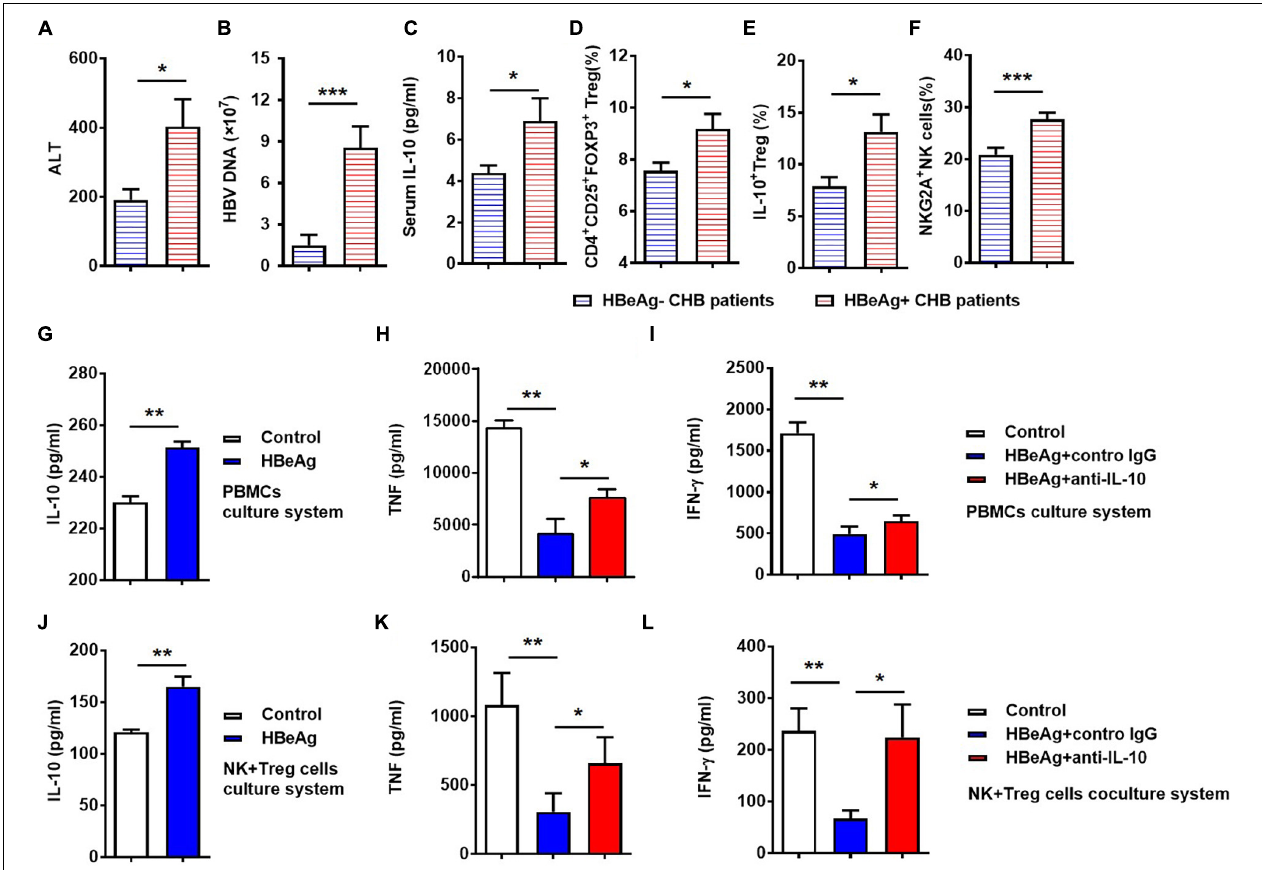
FIGURE 6 | HBeAg-induced IL-10 suppresses NK cell activation in vitro . (A) Serum ALT levels, (B) serum HBV DNA copy numbers, (C) serum IL-10 levels, (D) CD56 + NKG2A + NK expression, (E) percentages of Tregs, and (F) percentages of IL-10 + Tregs were compared in HBeAg-positive and -negative patients with CHB. (G–I) For vitro experiments, PBMCs (2 × 10 5 ) isolated from healthy donors were cultured with or without 500 ng/ml HBeAg and 50 ng/ml anti-human IL-10 neutralizing antibody or control IgG in the presence of 100 IU/ml IL-2 for 7 days and the concentrations of cytokines in culture supernatant measured using a CBA kit. (G) IL-10 levels in supernatant after culture of PBMCs from healthy donors with or without HBeAg. (H,I) IFN- γ and TNF levels in supernatant after culture of PBMCs with HBeAg, in the presence of anti-IL-10 or control IgG. (J–L) In the co-culture system, 5 × 10 4 NK cells and 5 × 10 4 Tregs were purified from